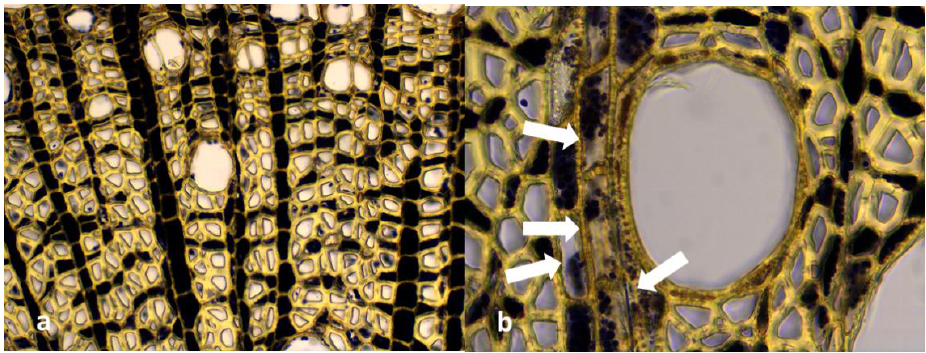
Figure 7. Sections of roots sampled from plants of treatment TiMi1, stained with Lugol ’s solution and observed in light microscopy. Starch is evidenced in dark in parenchymatous cells rays ( a ). Arrows indicate partial starch depletion in cells surrounding xylem vessels ( b ).